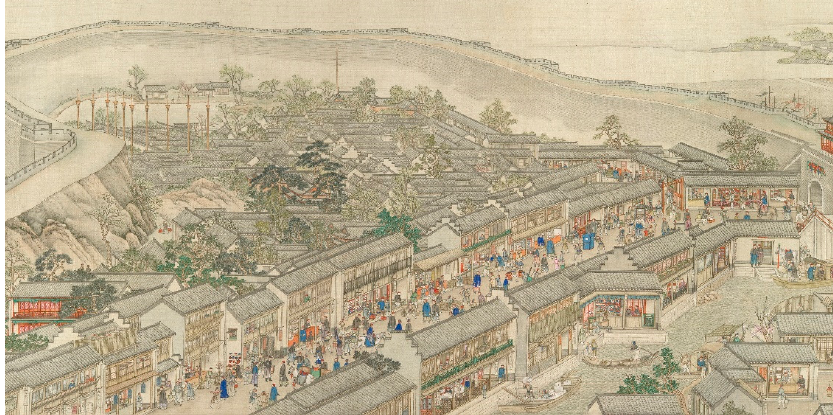
Land 2021 , 10 , x FOR PEER REVIEW Figure 8. Residences and marketplaces within Chang Gate [59]. Figure 8. Residences and marketplaces within Chang Gate [59].